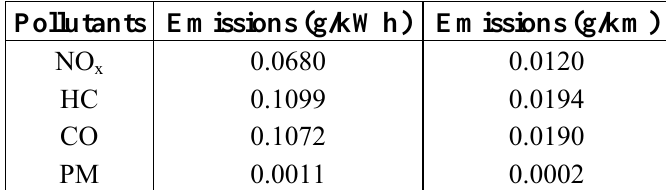
Table 16. Emissions from the LETHE © Sedan on a mixed